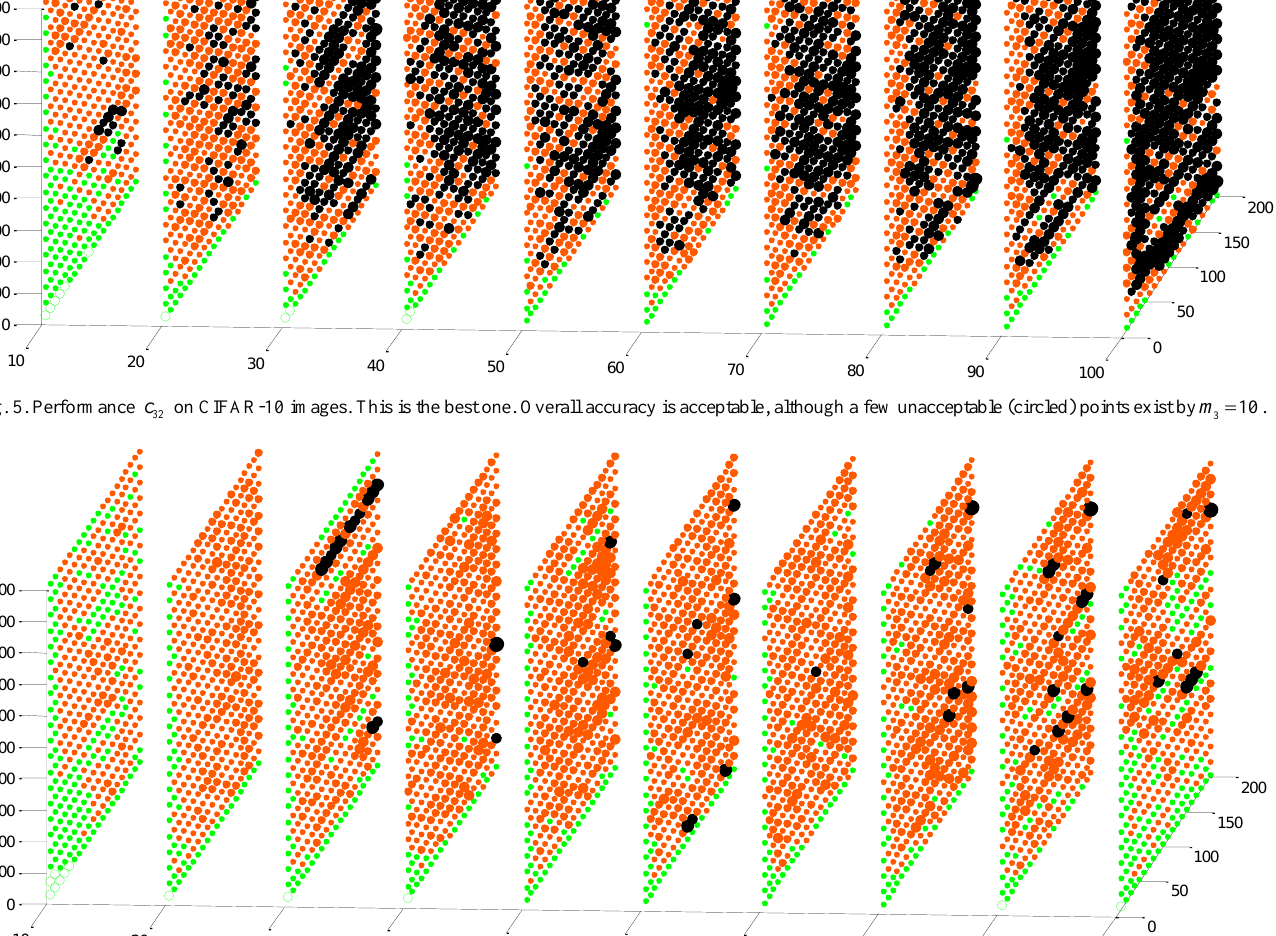
c (CIFAR-10). Locations of the top accuracies do not seem regular but similitude 28